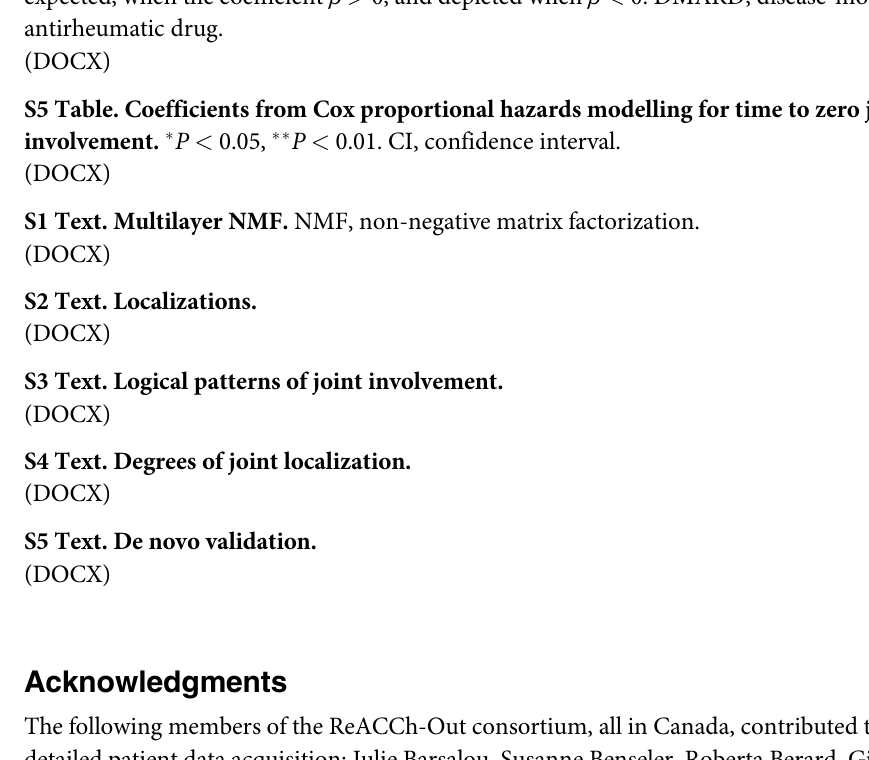
S4 Table. Associations between patient groups and degrees of localization and treatment decisions prior to subsequent visits. Associations are enriched, or observed more often than expected, when the coefficient β > 0, and depleted when β < 0. DMARD, disease-modifying antirheumatic drug. S5 Table. Coefficients from Cox proportional hazards modelling for time to zero joint involvement. � P < 0.05, �� P < 0.01. CI, confidence